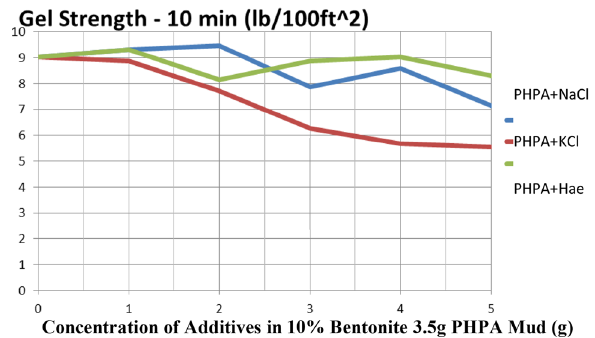
Fig. 21 Effect of NaCl on yield point of PHPA–bentonite mud in accordance with time